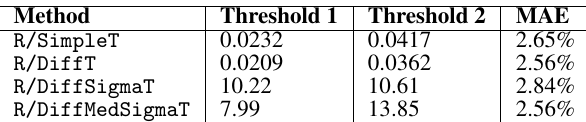
Table 2. Best threshold and performance for regression methods. MAE: Mean Absolute Error.